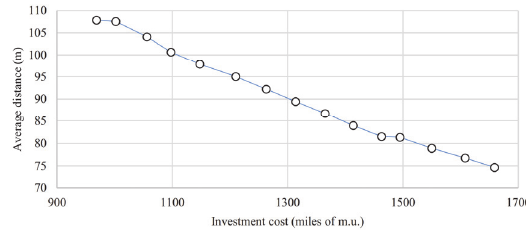
Fig. 6. Pareto front of the third scenario. Number of grid points = 20. Multi-objective approach =